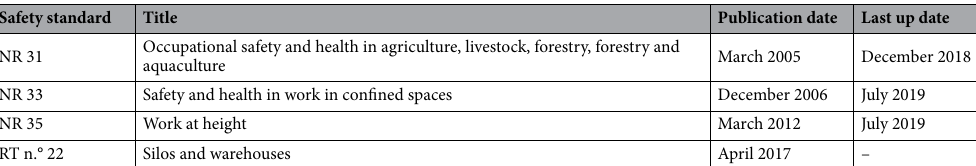
Table 2. Safety standards used in the Algorithm